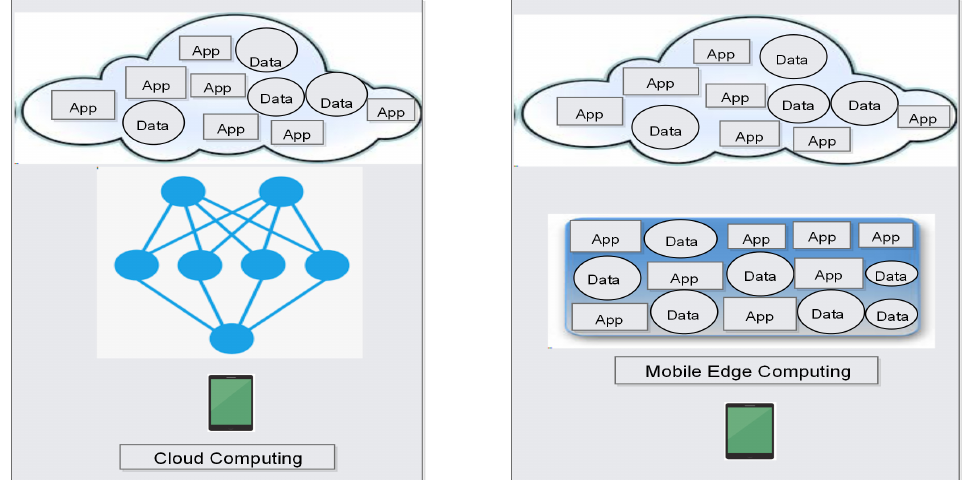
Figure 9. Pictorial representation of cloud computing vs. mobile edge